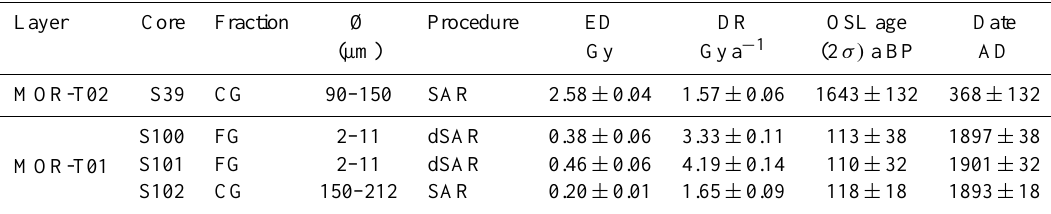
Table 3. OSL dating results obtained on coarse grain (CG) and fine grain (FG) fractions extracted from the sandy depth of MOR-T02 and MOR-T01 layers. Layer Core